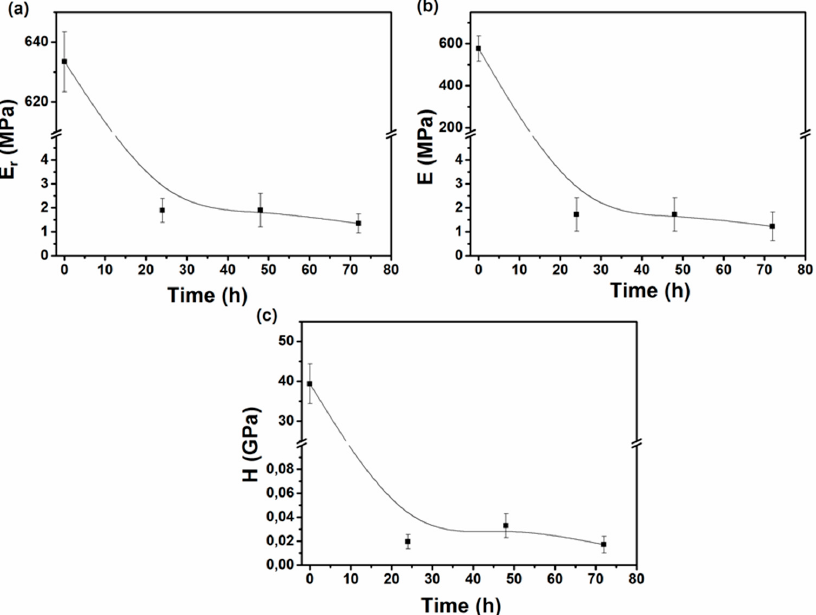
Figure 12. ( a ) Reduced modulus (Er); ( b ) Young’s modulus (E); and ( c ) hardness (H) values for the CS- g -PCL sample after submersion in α